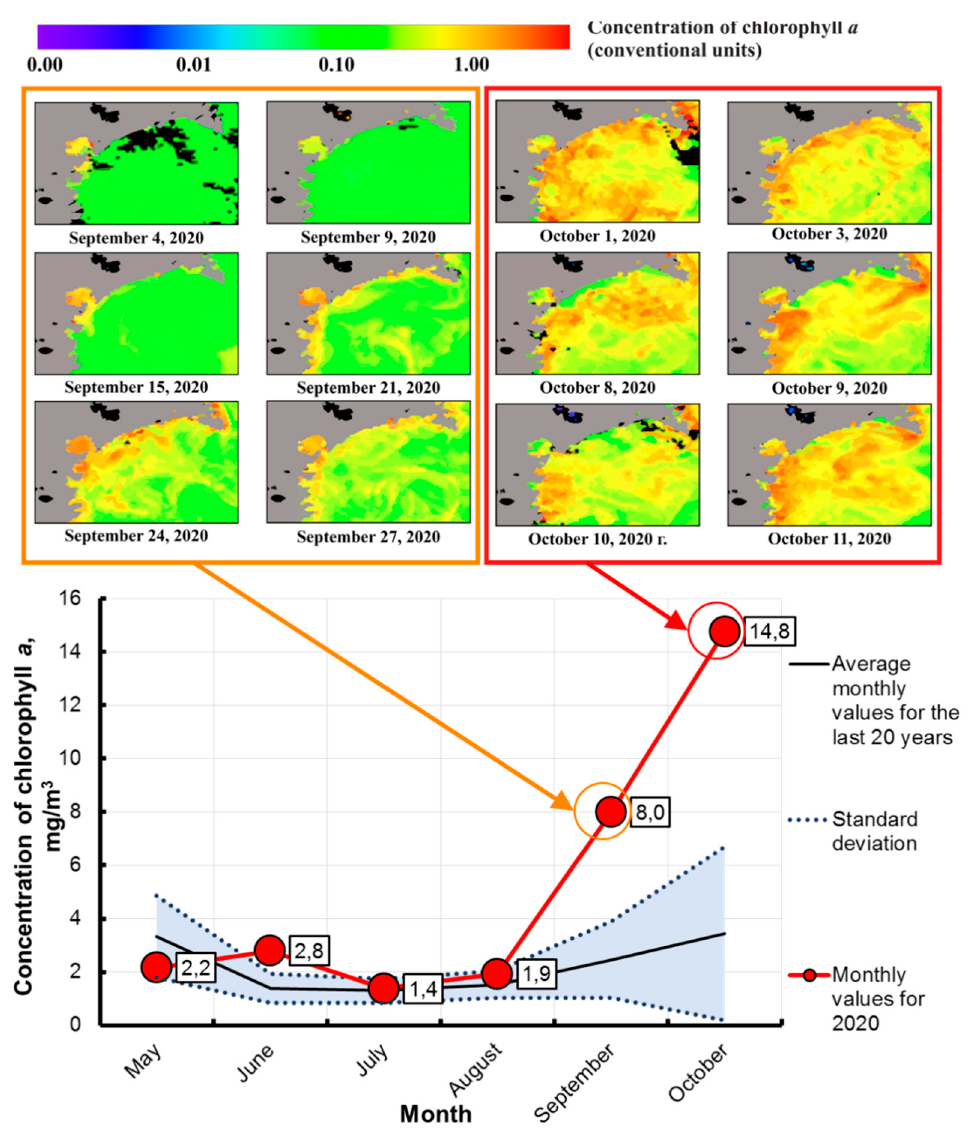
Figure 7. Information products formed during the assessment of phytoplankton bloom intensity in the Avacha Gulf: daily spatial distributions of chlorophyll ‐ a concentration (in conv. units) in September–October 2020, obtained from the processing of VIIRS data (NOAA satellites) (above); the graphs characterizing the monthly average values of chlorophyll ‐ a concentrations from May to October 2020 (red line), as well as from May to October averaged over the time period from 2000 to 2019. (blue line denotes average values, dashed lines denote standard deviation) characterizing the climatic norm (obtained from MODIS data processing (AQUA and TERRA satellites).